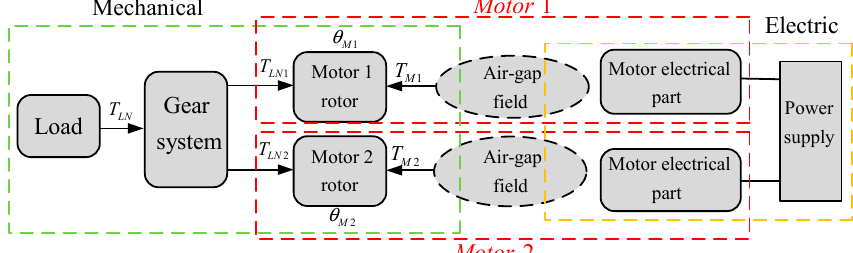
Figure 9. Schematic diagram of the electromechanical coupling model of the DEDS. The main parameters of the electromechanical coupling system are shown in Table 3.